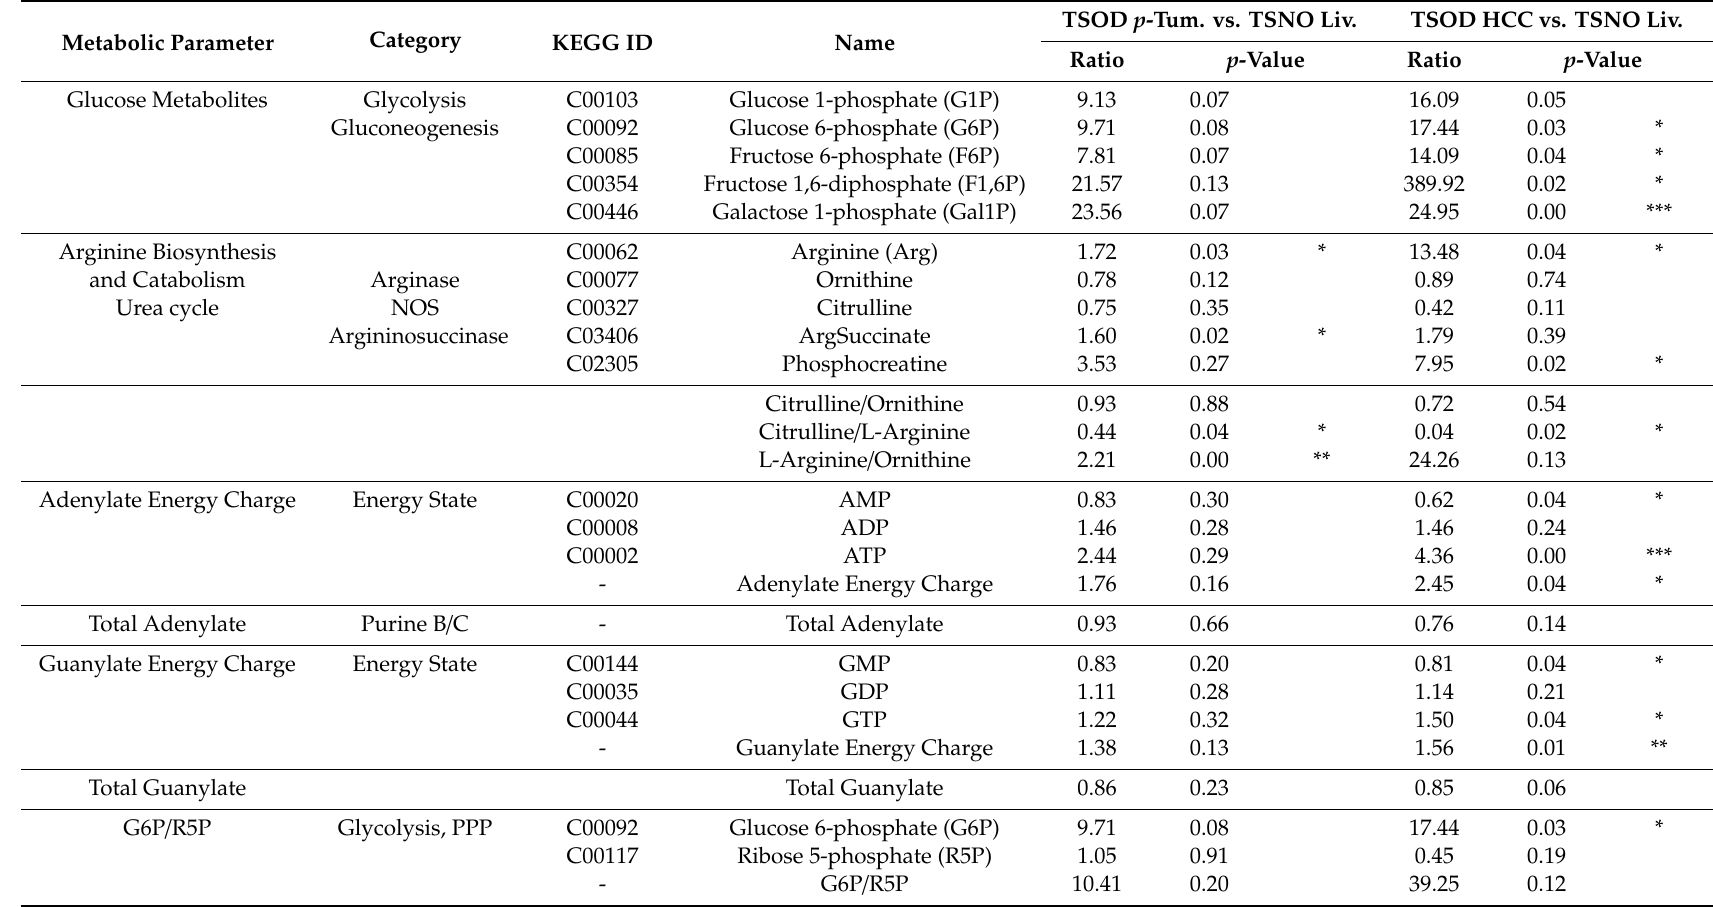
Table 1. Altered metabolites and metabolic parameters in the livers and tumors of TSOD